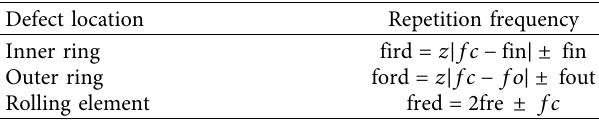
Table 6: Repetition frequencies of defective location. Defect